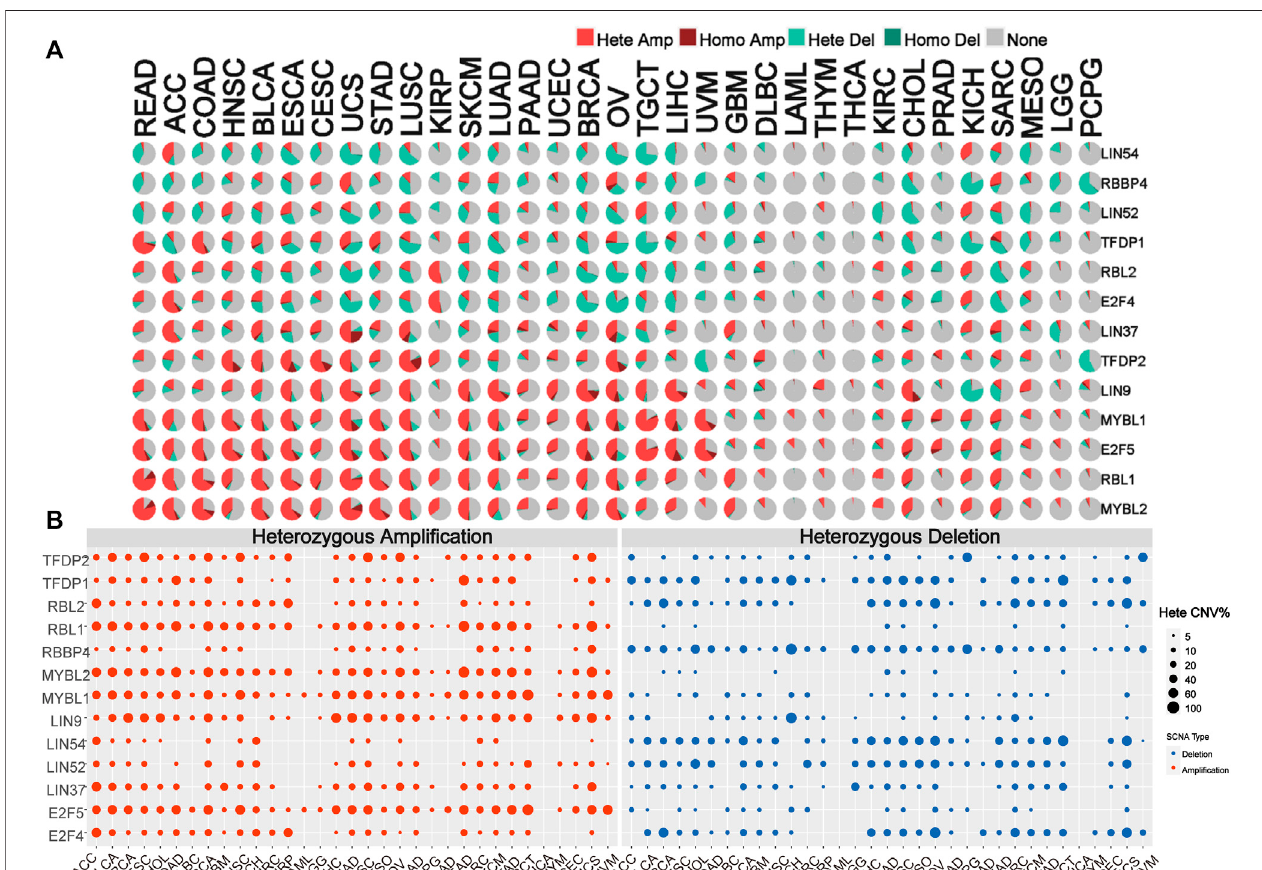
FIGURE3| Copy numbervariation(CNV)isthebasisoftheDREAMcomplexdysregulation. (A) Thecopy numbervariation(CNV)piechartshowstheproportionof different types of copy number variation for each gene in different cancers. Hete Amp, heterozygous ampli fi cation; Hete Del, heterozygous deletion; Homo Amp, homozygous ampli fi cation; Homo Del, homozygous deletion; None, no CNV. (B) The heterozygous CNV pro fi le shows the percentage of heterozygous CNV, including the percentage ofheterozygous CNV ampli fi cation and deletion for each gene ineach cancer. In each type ofcancer, only genes with aCNV of5% are shown asa dot in the